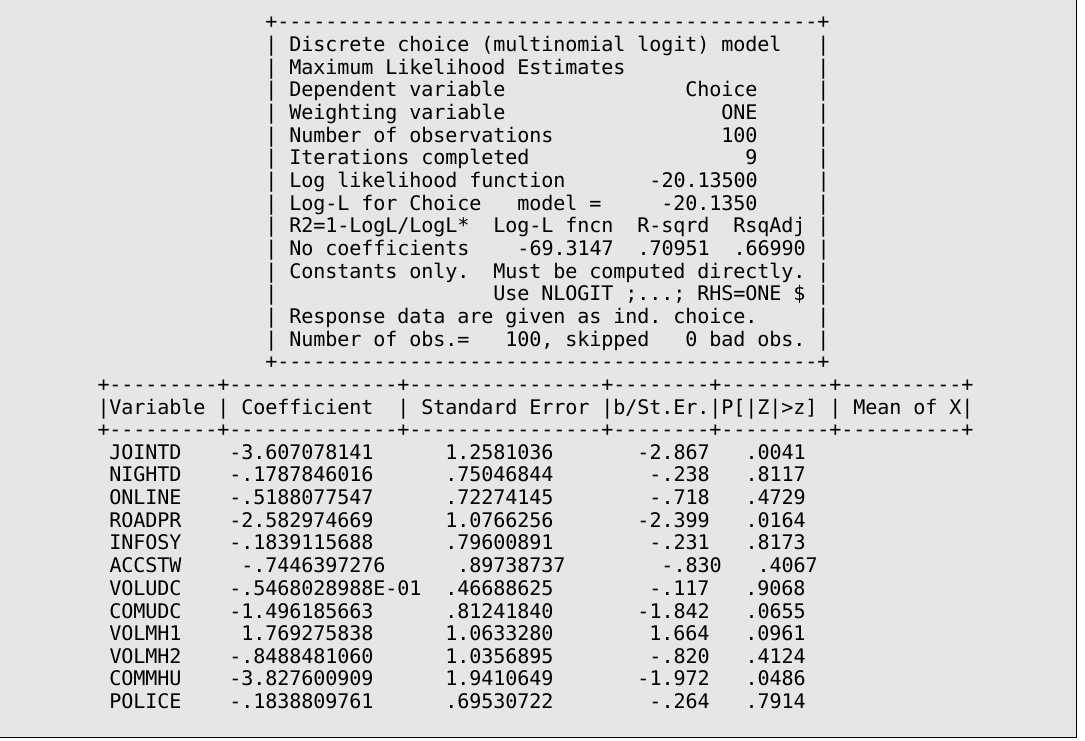
Figure 1. Output report provided by Limdep® for the multinomial logit